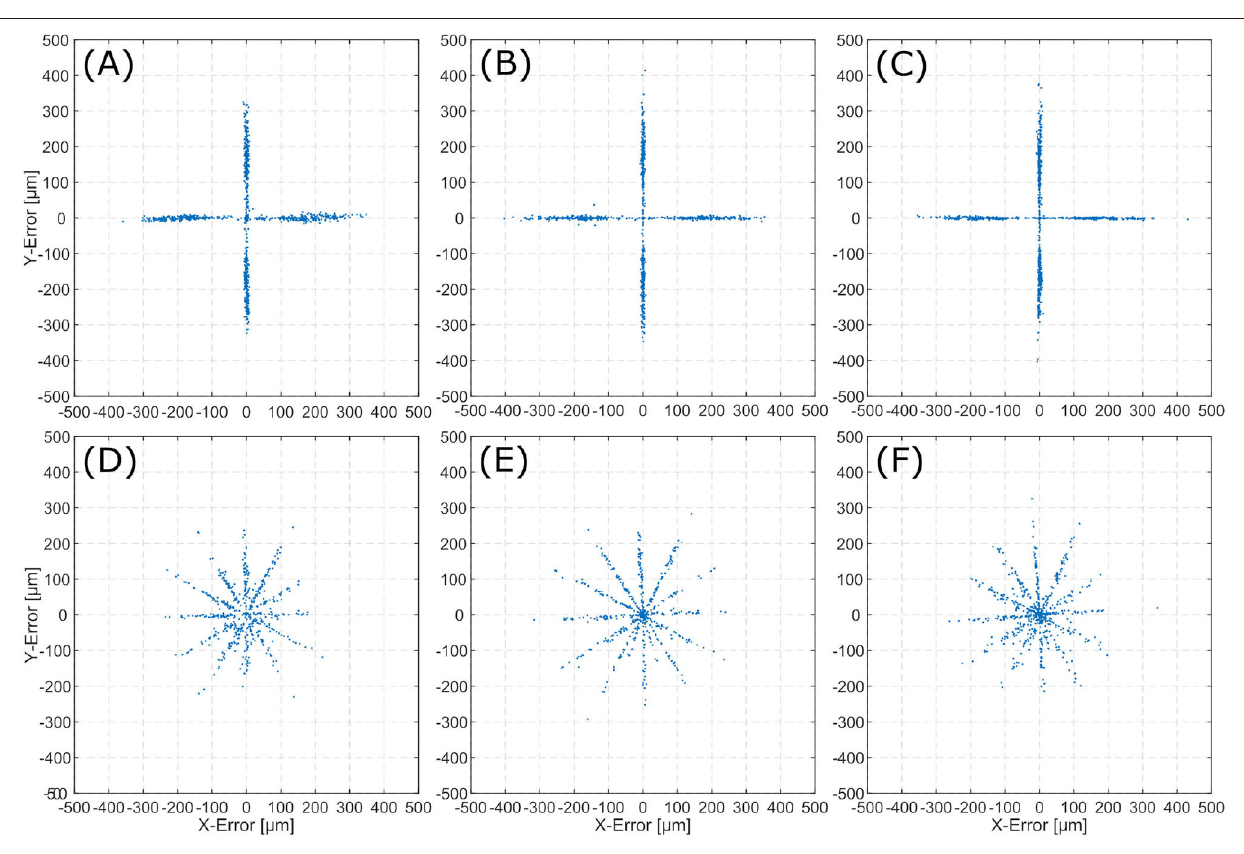
FIGURE 6 | Error ( E E ) distribution for the evaluated scenes. The top row displays 2D-errors for the linear trajectories on TBP (A) , TBPs (B) , and CTP (C) . The bottom row displays 2D-errors for the spiral trajectories on TBP (D) , TBPs (E) , and CTP (F)